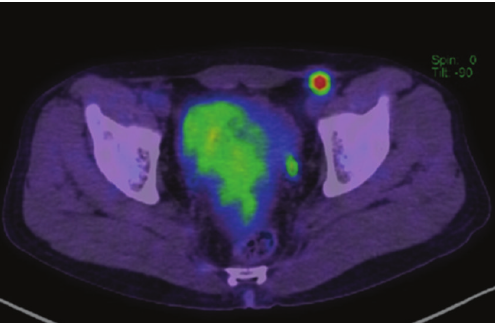
Figure 1: FDG-PET revealed concentration of FDG in the left inguinal area. The size of the mass was